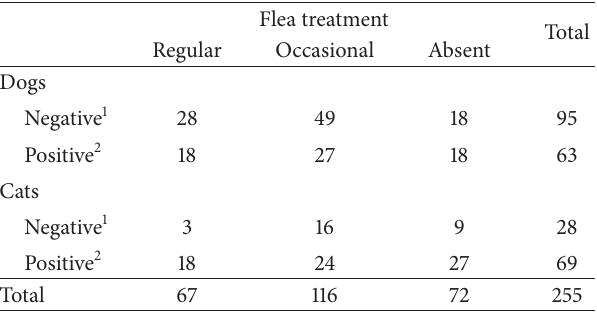
Table 2: Results of the examination of the coat brushing material in dogs and cats according to the flea treatment